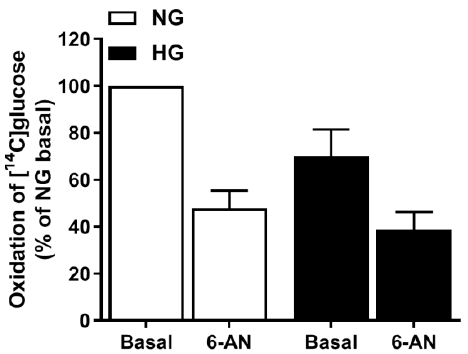
Figure 7. Involvement of the pentose phosphate pathway. Myotubes were exposed to 5.5 mM (NG) or 20 mM glucose (HG) with or without 50 µM 6-aminonicotinamide (6-AN) the last four days of the differentiation period and then incubated with D -[ 14 C(U)]glucose (0.5 µCi/mL, 200 µM) for 4 h. Oxidation was measured as CO 2 trapped in a filter and counted by liquid scintillation. Data are presented as means ± SEM relative to NG basal from four individual experiments (n = 4). Data representing NG basal (100%): 26.6 ± 10.3 nmol/mg protein.